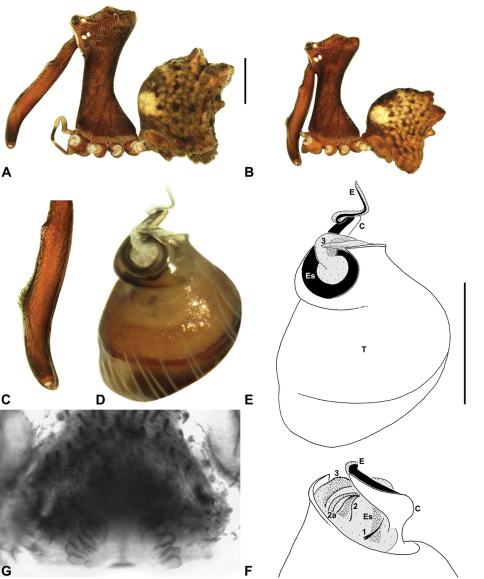
Austrarchaea monteithi sp. n. A–B, Cephalothorax and abdomen, lateral view: A, allotype female (AMS KS114976) from Gibralter Range National Park, New South Wales; B, holotype male (AMS KS114977) from Gibralter Range National Park, New South Wales. C, Holotype male chelicerae, lateral view, showing accessory setae. D–F, Holotype male pedipalp: D–E, bulb, retrolateral view; F, detail of distal tegular sclerites, prodistal view. G, Allotype female internal genitalia, dorsal view. C = conductor; E = embolus; Es = embolic sclerite; T = tegulum; (TS)1–3 = tegular sclerites 1–3. Scale bars: A–B = 1.0 mm; E = 0.2 mm.